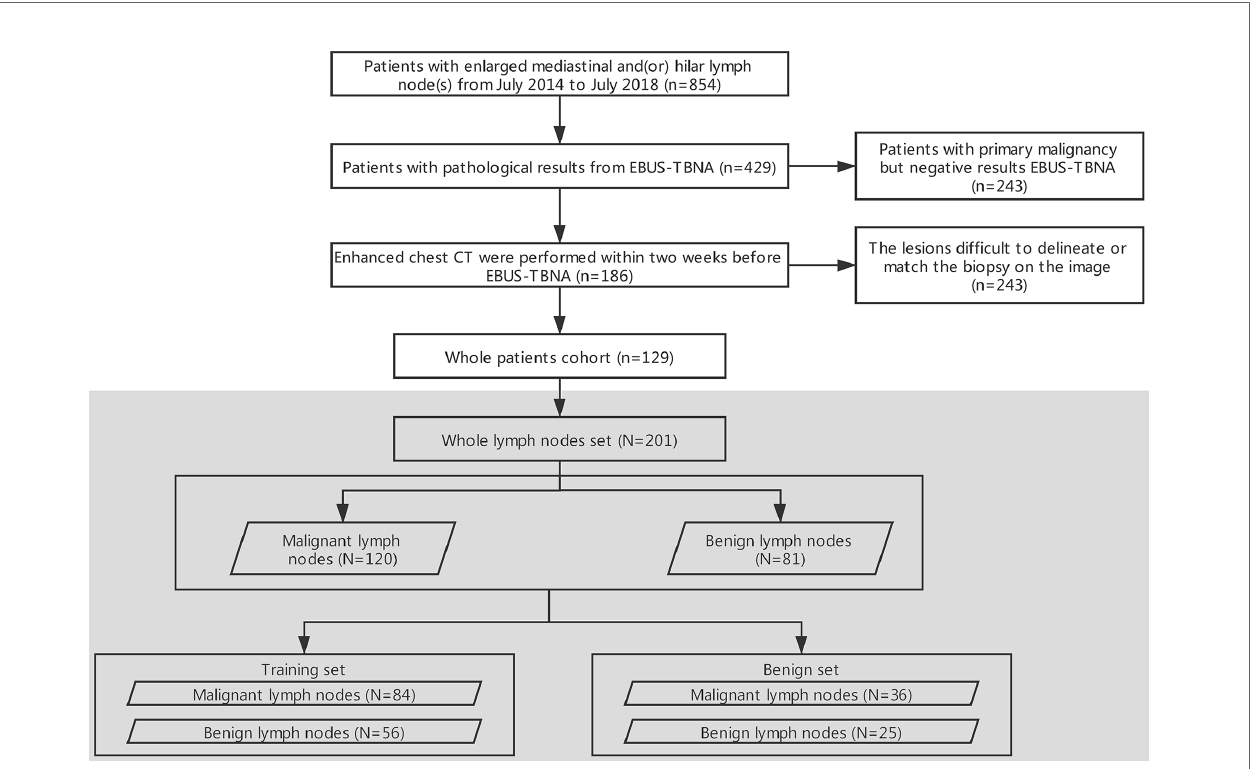
FIGURE 1 | Flowchart of the selection of patients and data assignment. EBUS-TBNA, endobronchial ultrasound-guided transbronchial needle aspiration; n: patients, N: lymph